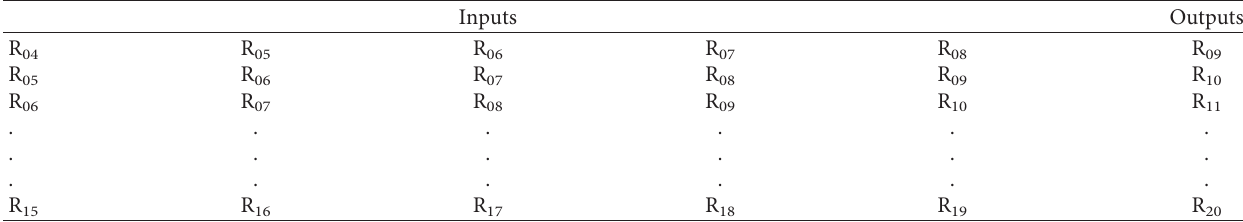
Table 2: MLP network, data matrix for further rainfall forecasting.